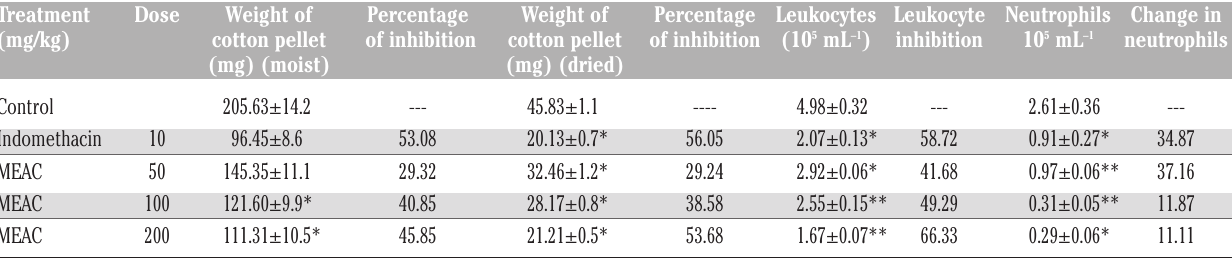
Table 1. Effect of the methanol extract of Anthocephalus cadamba stem bark on cotton pellet-induced granuloma in rats and on leuko- cyte migration in peritoneal exudation in carrageenan-induced mice. Treatment Dose